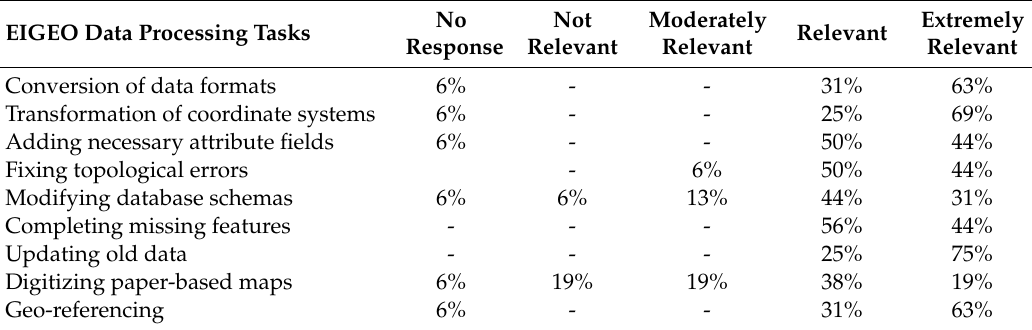
Table 4. Data processing tasks for EIGEO operations